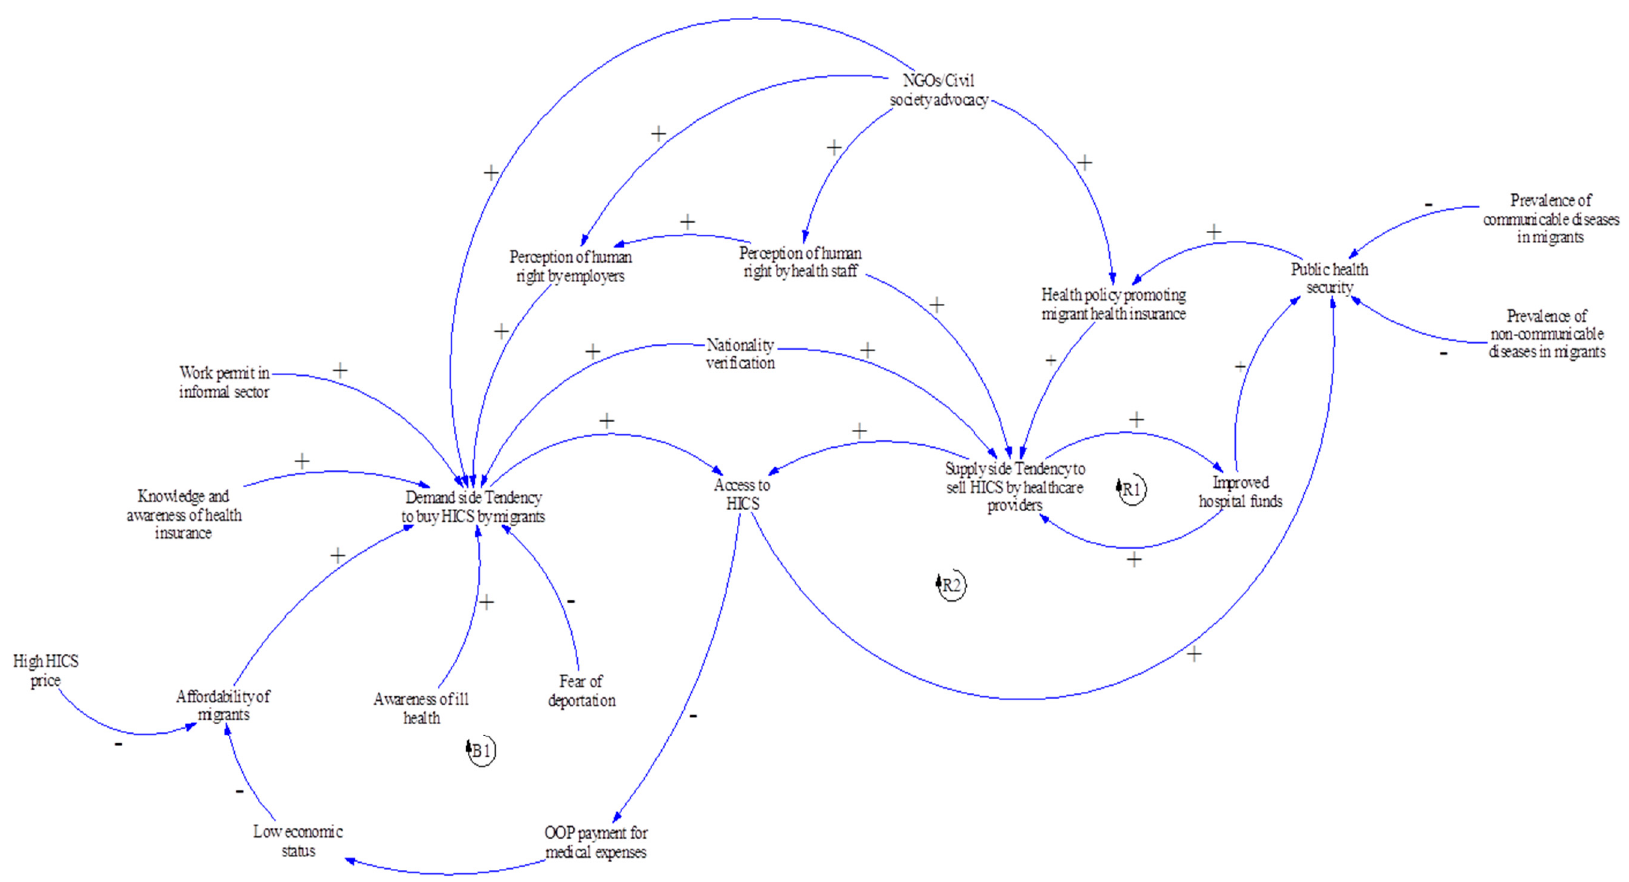
Figure 4. The CLD of the dynamics of access to health insurance (Health Insurance Card Scheme (HICS)) by migrant workers. Note: OOP = Out-of-pocket. (+) positive influence (-) negative influence.